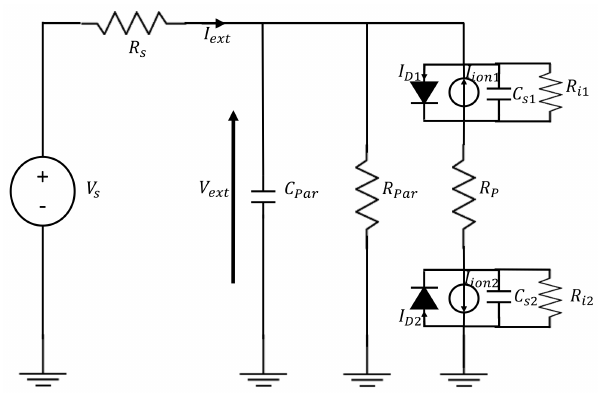
Figure 3. Measurement setup equivalent circuit. C Par and R Par model the cable parasitic capacitances and resistive